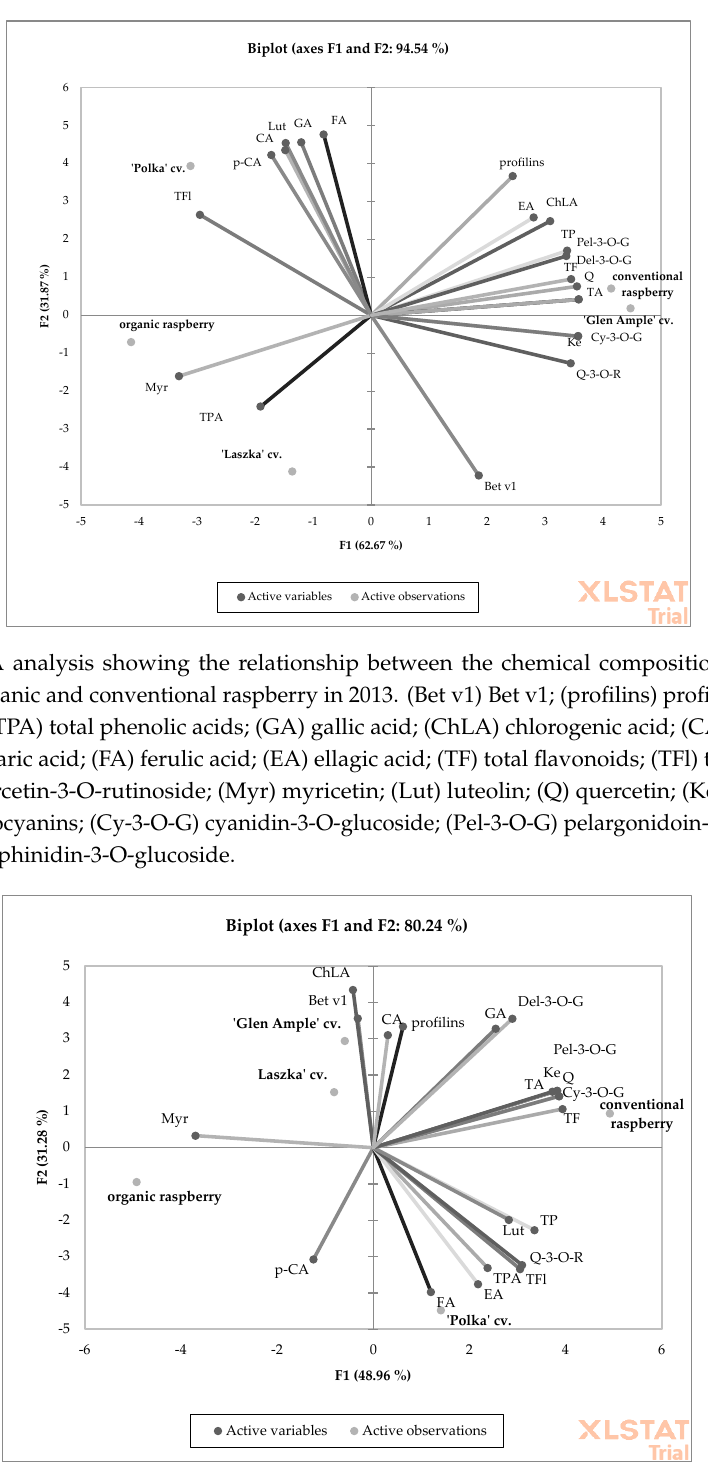
Figure 3. PCA analysis showing the relationship between the chemical composition and allergy potential of organic and conventional raspberry in 2014. (Bet v1) Bet v1; (profilins) profilins; (TP) total polyphenols; (TPA) total phenolic acids; (GA) gallic acid; (ChLA) chlorogenic acid; (CA) caffeic acid; ( p -CA) p -coumaric acid; (FA) ferulic acid; (EA) ellagic acid; (TF) total flavonoids; (TFl) total flavonols; (Q-3-O-R) quercetin-3-O-rutinoside; (Myr) myricetin; (Lut) luteolin; (Q) quercetin; (Ke) kaempferol; (TA) total anthocyanins; (Cy-3-O-G) cyanidin-3-O-glucoside; (Pel-3-O-G) pelargonidoin-3-O-glucoside; (Del-3-O-G)delphinidin-3-O-glucoside.